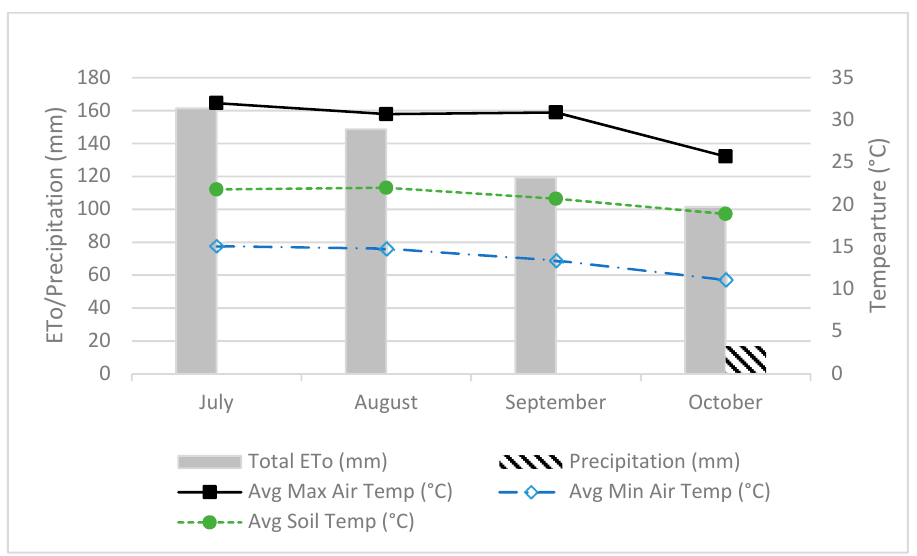
Figure 4. Weather data recorded during experimental period using a CIMIS station on site. ETo: Reference evapotranspiration.